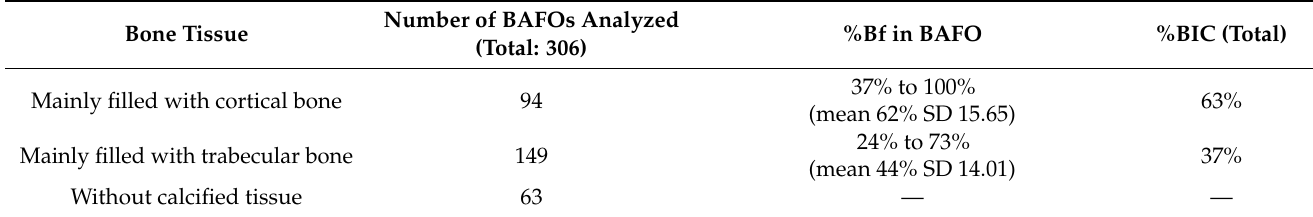
Table 1. Summary of quantitative analysis of bone tissue observed in the BAFOs (Total samples = 15). For BAFO, %Bf, and %BIC definitions see the methodology segment. SD = standard deviation.